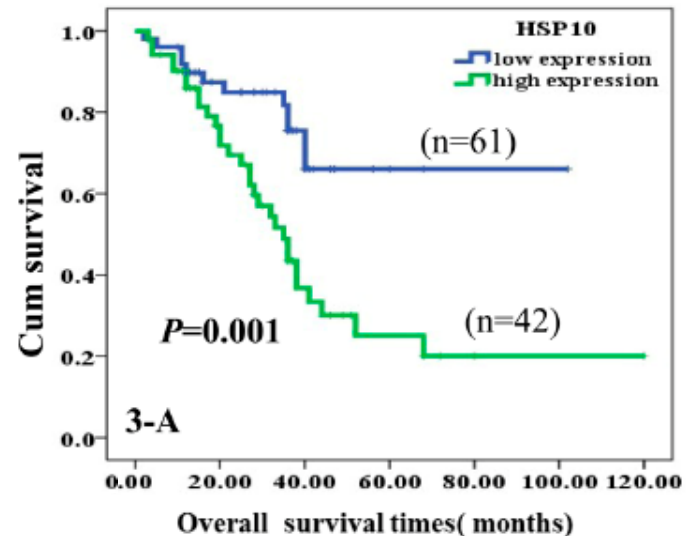
Figure 4. Kaplan-Meier curves according to expression of HSP10 protein divided into high and low expression. High expression of HSP10 was significantly correlated to poor prognosis of astrocytoma patients ( p = 0.001, two-sided)